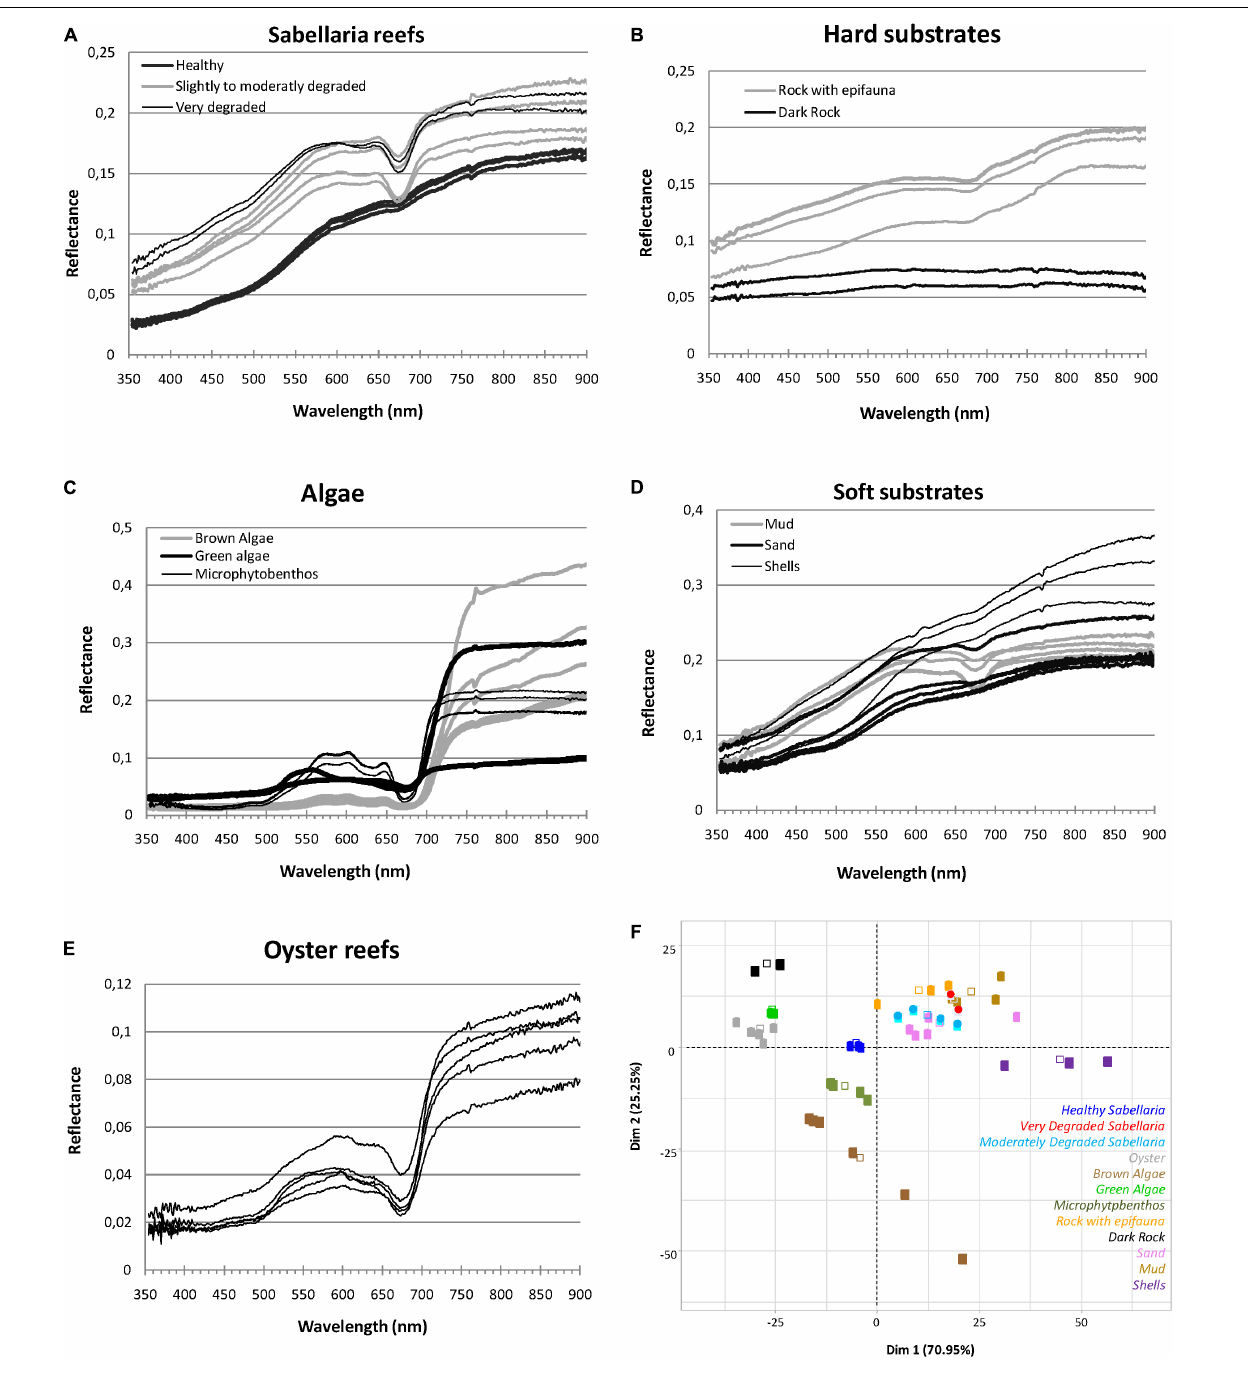
FIGURE 5 | Spectral signature of Sabellaria alveolata reef (A) and associated benthic features (B–E) with the corresponding PCA analysis biplot of the two first dimensions (F) .